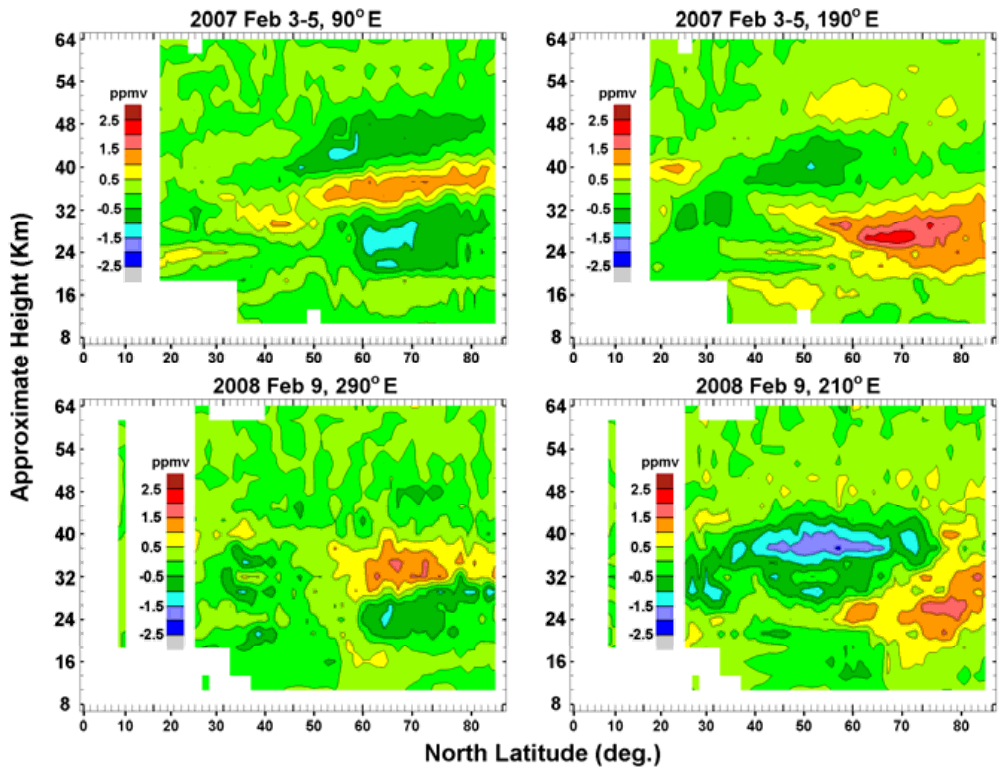
Fig. 15. Contour plots of ozone mixing ratio (the zonal means are subtracted) at the chosen longitudinal sectors that pass through the vortex (left side) and the anticyclone (right side) for two dates (3–5 February 2007 and 9 February